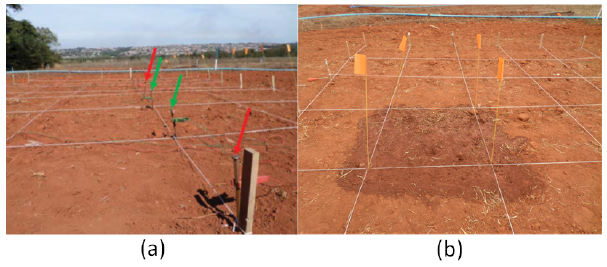
Figure 14. Preparation of area for application of lateral profiling method: ( a ) insertion of electrodes and ( b ) area with insertion of water.